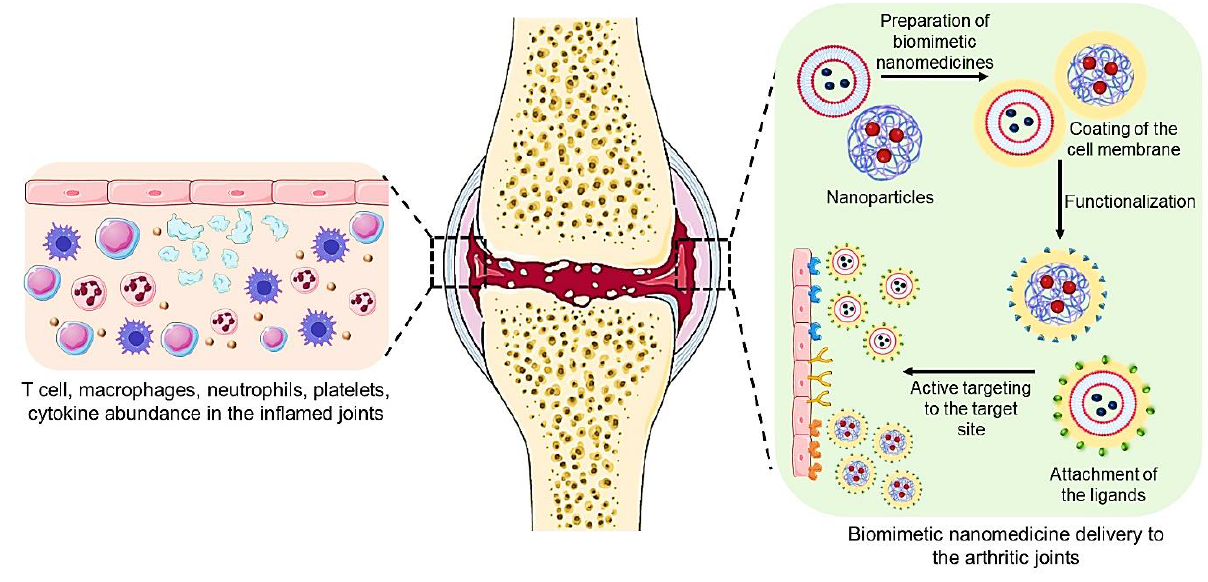
Figure 9. Biomimetic nanomedicines with targeting ligands.